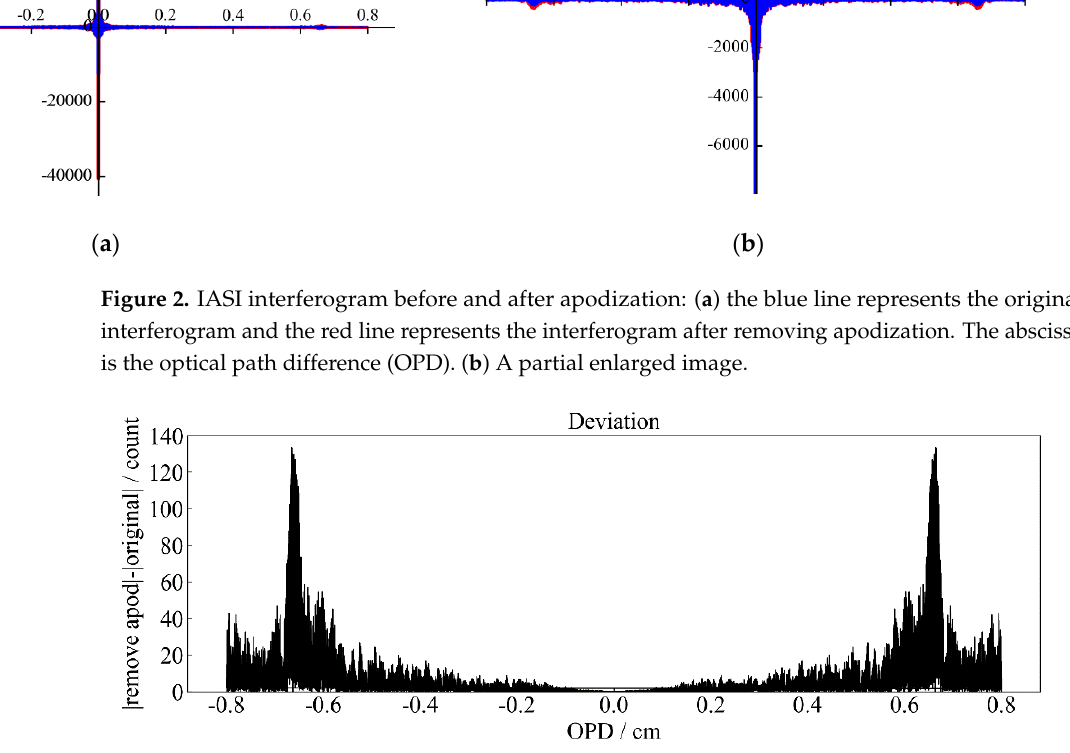
Figure 2. IASI interferogram before and after apodization: ( a ) the blue line represents the original interferogram and the red line represents the interferogram after removing apodization. The ab- scissa is the optical path difference (OPD). ( b ) A partial enlarged image.